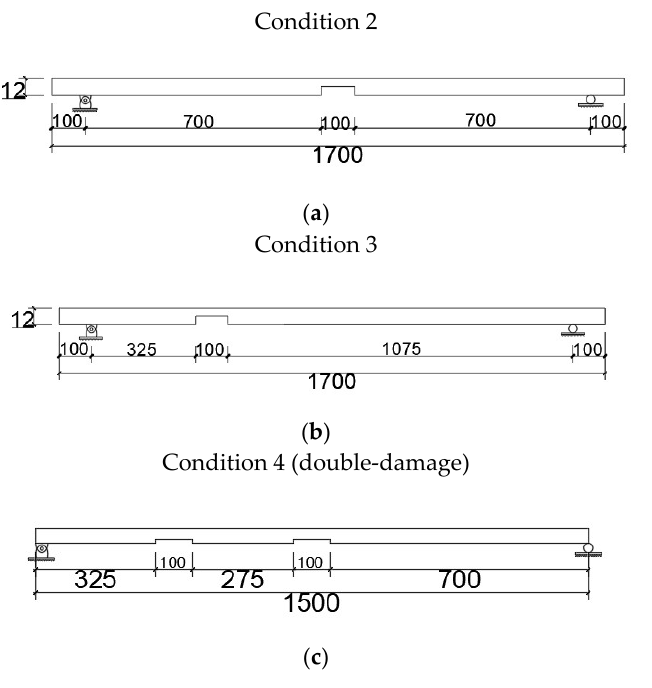
Figure 2. ( a ) Schematic diagram of midspan damage condition; ( b ) schematic diagram of damage